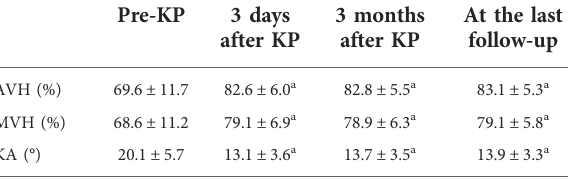
TABLE 2 Mean restoration in the vertebral height and kyphotic angle. Pre-KP 3 days 3 months after KP after KP